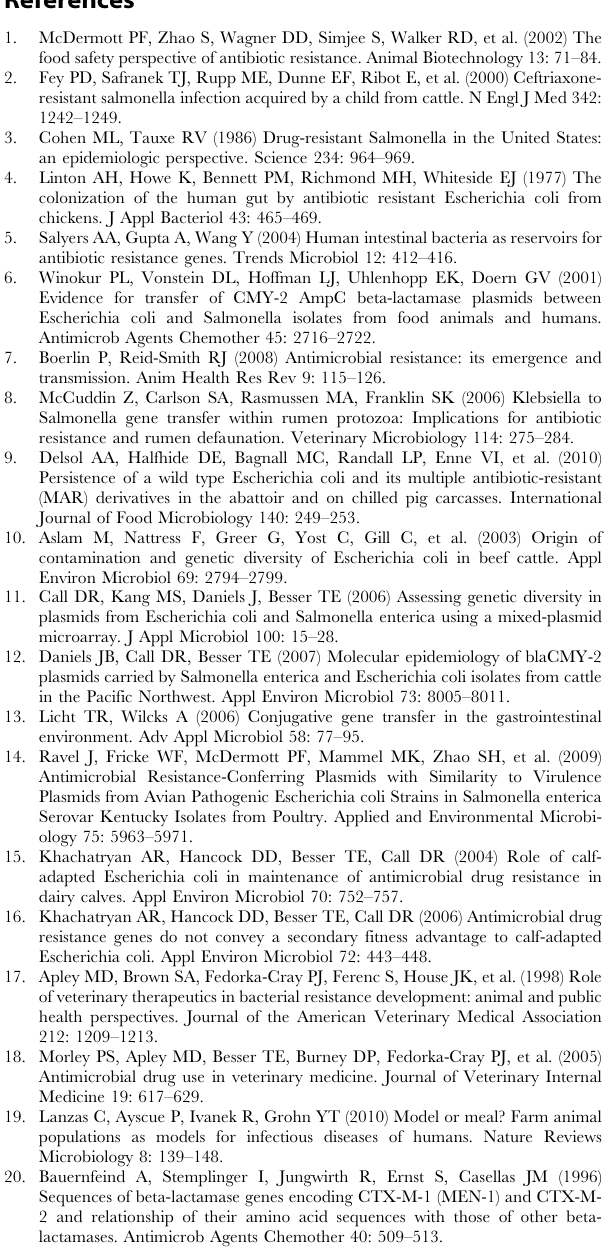
Table S1 Modeled scenarios of treatment of cattle with ceftiofur, and experimental data considered for